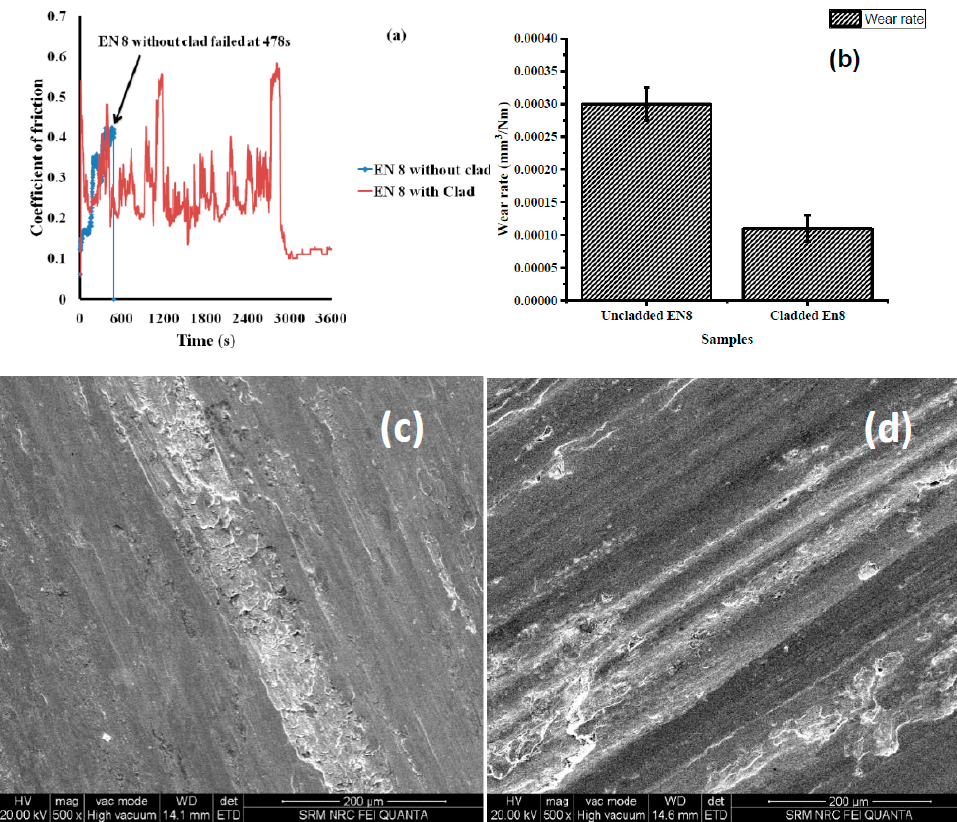
Figure 7. ( a ) Experimental reading showing failure of uncladded EN 8 (base metal) pin. ( b ) Wear rate comparison graph between cladded and uncladded EN 8. ( c ) SEM image of pin surface of uncladded EN 8 after 478 s. ( d ) SEM image of pin surface of cladded EN 8 after 3600 s.